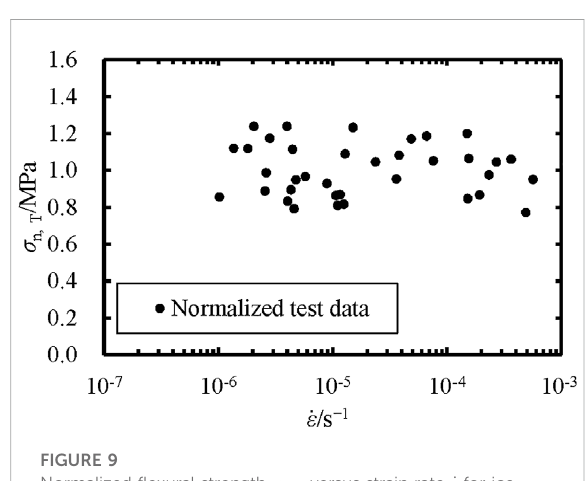
FIGURE 9 Normalized fl exural strength σ n, T versus strain rate _ ε for ice